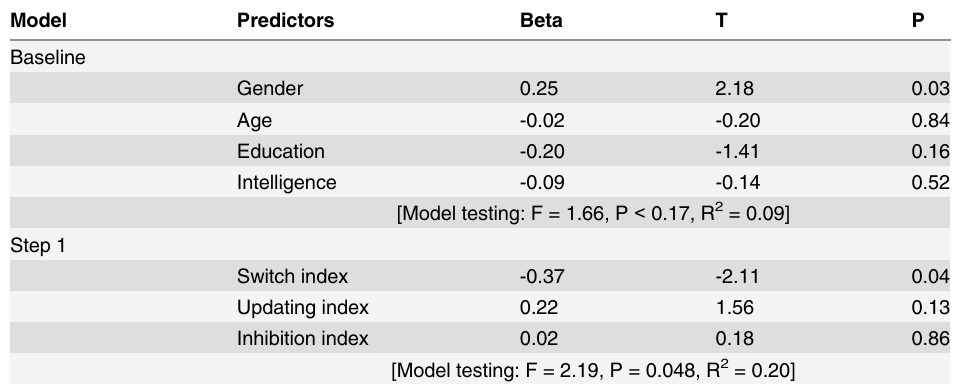
Table 2. Regressing pathological dissociation with demographical variables, intellectual quotient, executive control and traumatic experience in hierarchical regression analysis.